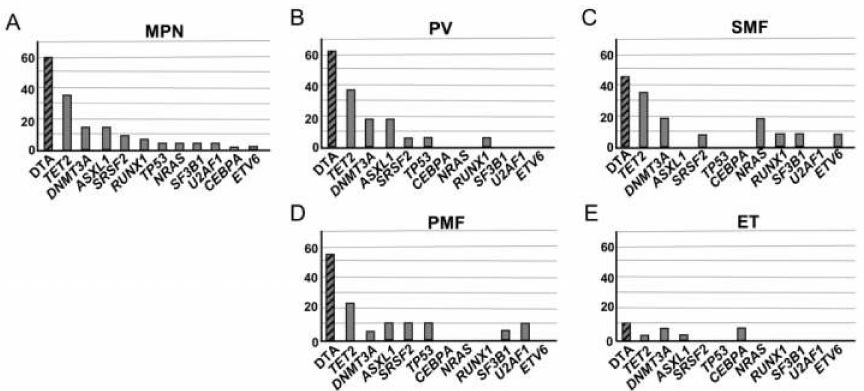
Figure 1. Most frequent non-driver gene mutations. ( A ) For the whole patient cohort ( n = 68), and for each neoplasia separately, ( B ) polycythemia vera (PV) ( n = 16), ( C ) secondary myelofibrosis (SMF) ( n = 11), ( D ) primary myelofibrosis (PMF) ( n = 16), and ( E ) essential thrombocythemia (ET) ( n = 25). DTA genes ( DNMT3A, TET2, ASXL1 ) were the most frequently mutated in both the whole cohort and individual neoplasias. Hatched bars represent the sum of mutations in the DTA